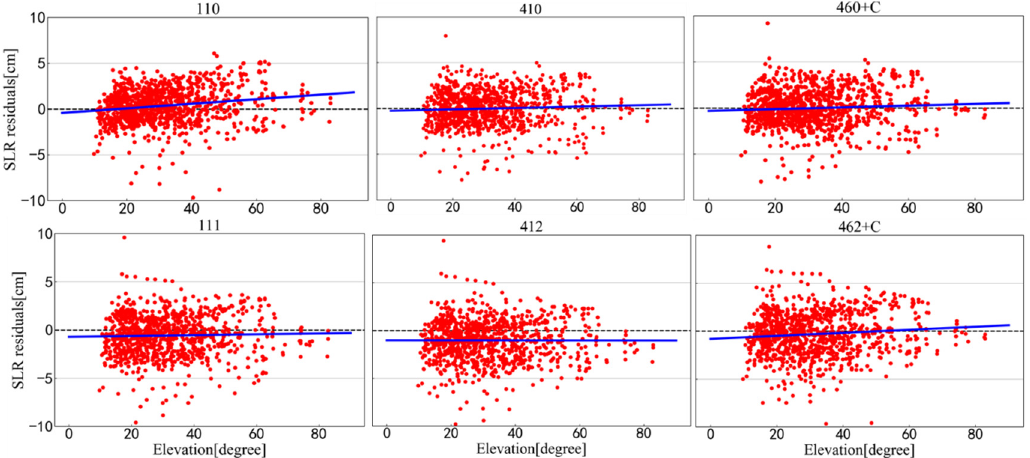
Figure 3. SLR residuals (red dot) with respect to the elevation angle for all sites, with a trend line (blue). All six PEA solutions are displayed for comparison.